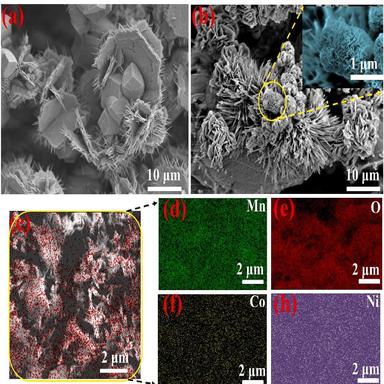
SEM image of (a) CoMn2O4 nanomaterials and (b) the Ni-Co/CoMn2O4 nanomaterials at different magnifications. (e-h) The element mapping images of different elements of O, Mn, Co, and Ni in Ni-Co/CoMn2O4 composites.